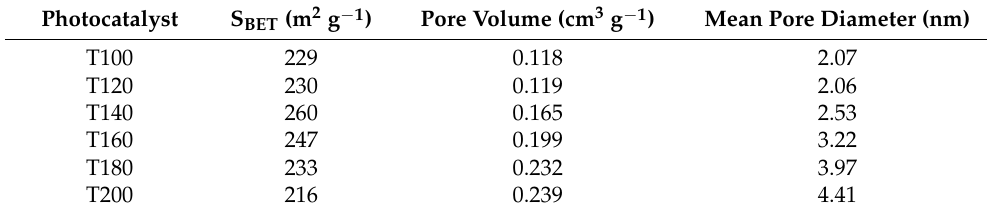
Table 1. Specific surface area S BET , pore volume, and pore size of TiO 2 NP